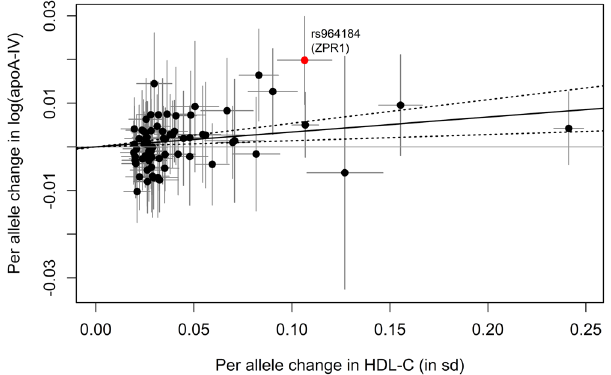
estimate we got using all 58 SNPs (Table 3). By adjusting for HDL-C and TG, the beta estimate remained nearly the same but it became non-significant β adjusted = − 0.0259 (95% CI = [ − 0.0480, − 0.0039], p-value = 0.0213, see Table 3). Excluding the 12 SNPs that were in LD with SNPs associated with any of the other traits (Supplementary Table 9) and applying the MR-IVW method to the remaining 46 SNPs did not markedly change the causal estimate obtained using all 58 SNPs, but it became non-significant (p = 0.0144, Supplementary Table 15 and Supplementary Figure 6). The application of the multivariable Mendelian randomization approach to the 57 SNPs not in LD with SNPs from the non-lipid traits gave comparable results to using the adjustment on all 58 SNPs (p = 0.0395, Supplementary Table 15 and Supplementary Figure 7). Using MR-Egger regression and the weighted median estimation method, LDL-C remained associated with apoA-IV (Supplementary Table 16 and Supplementary Figure 16). Taking the 40 SNPs associated with triglyceride levels and using the MR-IVW method, a significant causal estimate of β obtained. As for LDL-C levels, an increase in TG levels will result in a decrease of apoA-IV concentrations. Adjusting for HDL-C and LDL-C in the multivariable MR resulted in nearly the same statistically significant